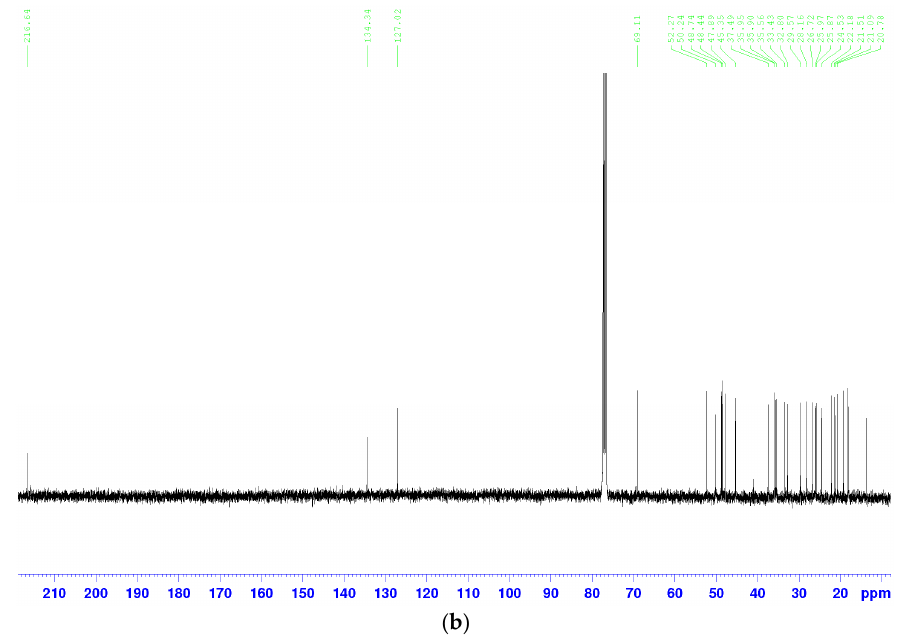
Figure 2. ( a ) 1 H-NMR and ( b ) 13 C-NMR spectral data of 24( E )-cycloart-24-ene-26-ol-3-one.